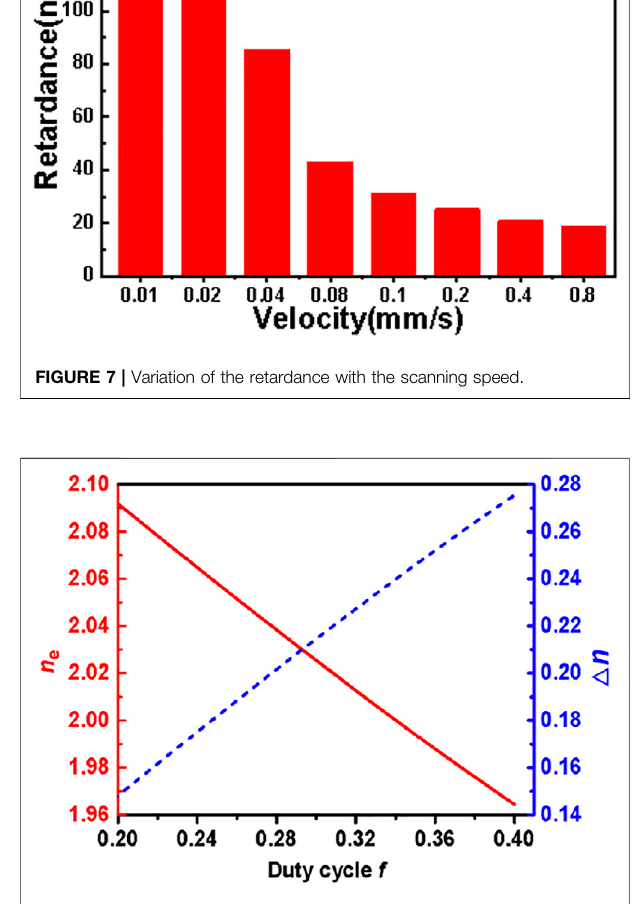
FIGURE 8 | Variation of n e and Δ n with duty cycle f .